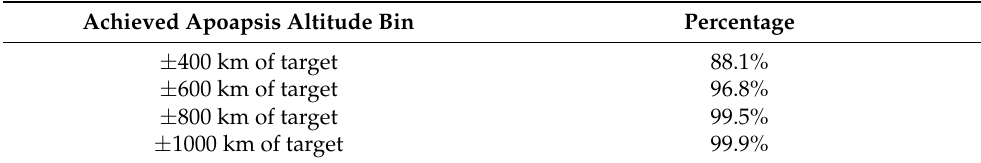
Figure 11. Scatter plots of the peak deceleration, peak stagnation-point heat rate and the total heat load for aerocapture at Mars. The dotted lines indicate the 99.87 percentile values. Table 5. Statistics for Mars aerocapture orbit apoapsis